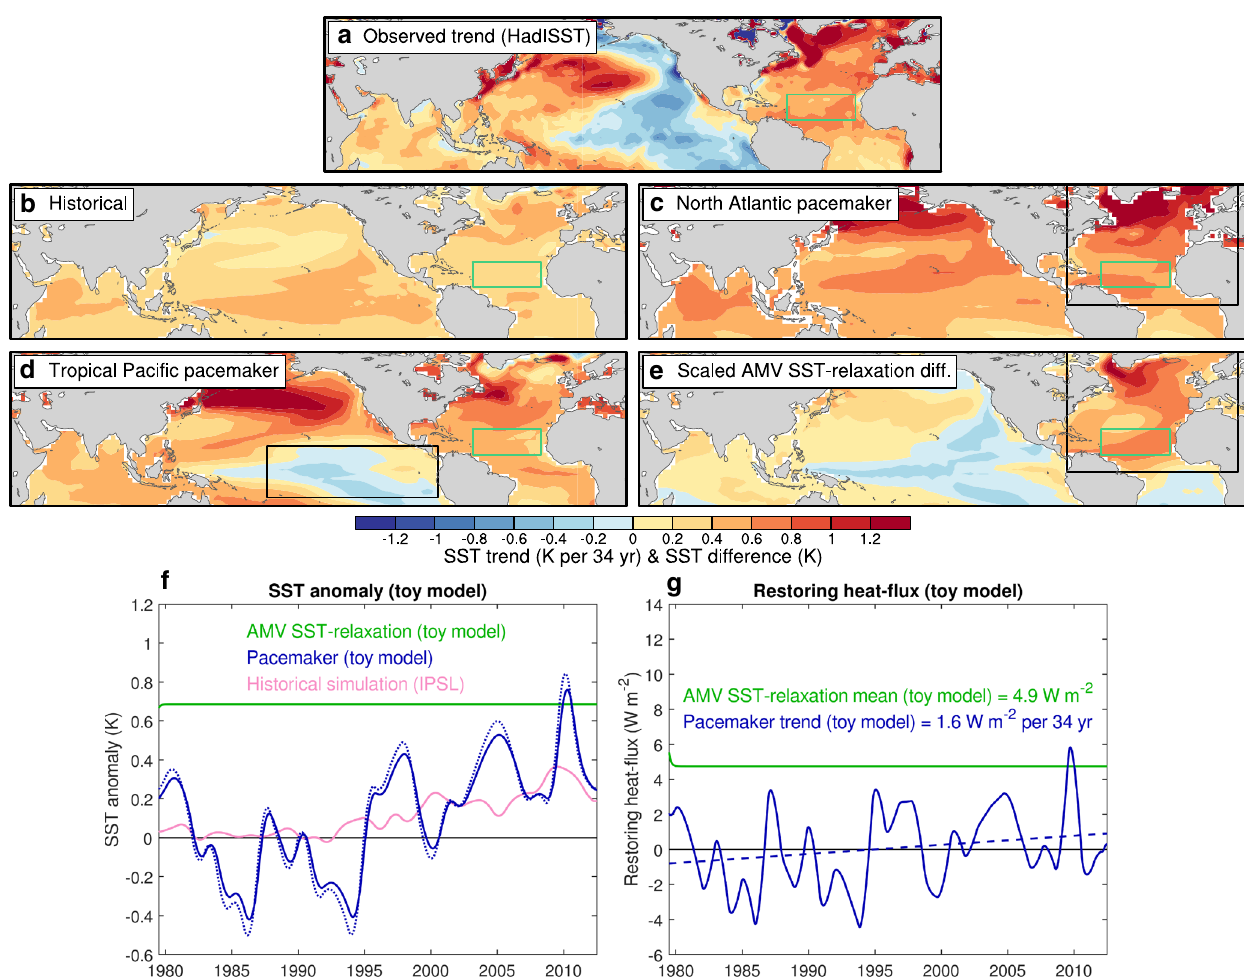
Fig. 5 Examining the role of the North Atlantic in controlling global SST trends over recent decades. SST trend over the period 1979-2012 in ( a ) observed SSTs from HadISST; ( b ) Historical IPSL ensemble mean; ( c ) North Atlantic IPSL pacemaker ensemble mean; ( d ) Tropical Paci fi c pacemaker ensemble mean; ( e ) Scaled IPSL SST-relaxation difference (i.e. scaled version of Fig. 1a). ( f ) Subtropical SST anomaly evolution from the SST-restoring toy model discussed in the text (examining the trend and effective trend shown in panels ( c ) & ( e )), shown for an idealised AMV SST-relaxation simulation, North Atlantic pacemaker, along with the ensemble mean subtropical SST anomaly from the IPSL historical simulation. ( g ) Restoring heat- fl ux evolution for the toy model simulations shown in ( f ); the dashed line shows the toy model pacemaker